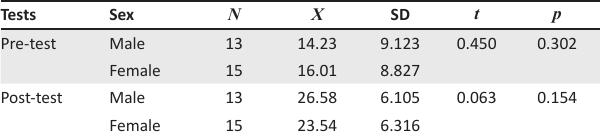
TABLE 4: The experimental group’s Brief Infant-Toddler Social and Emotional Assessment pre- and post-test scores by gender.